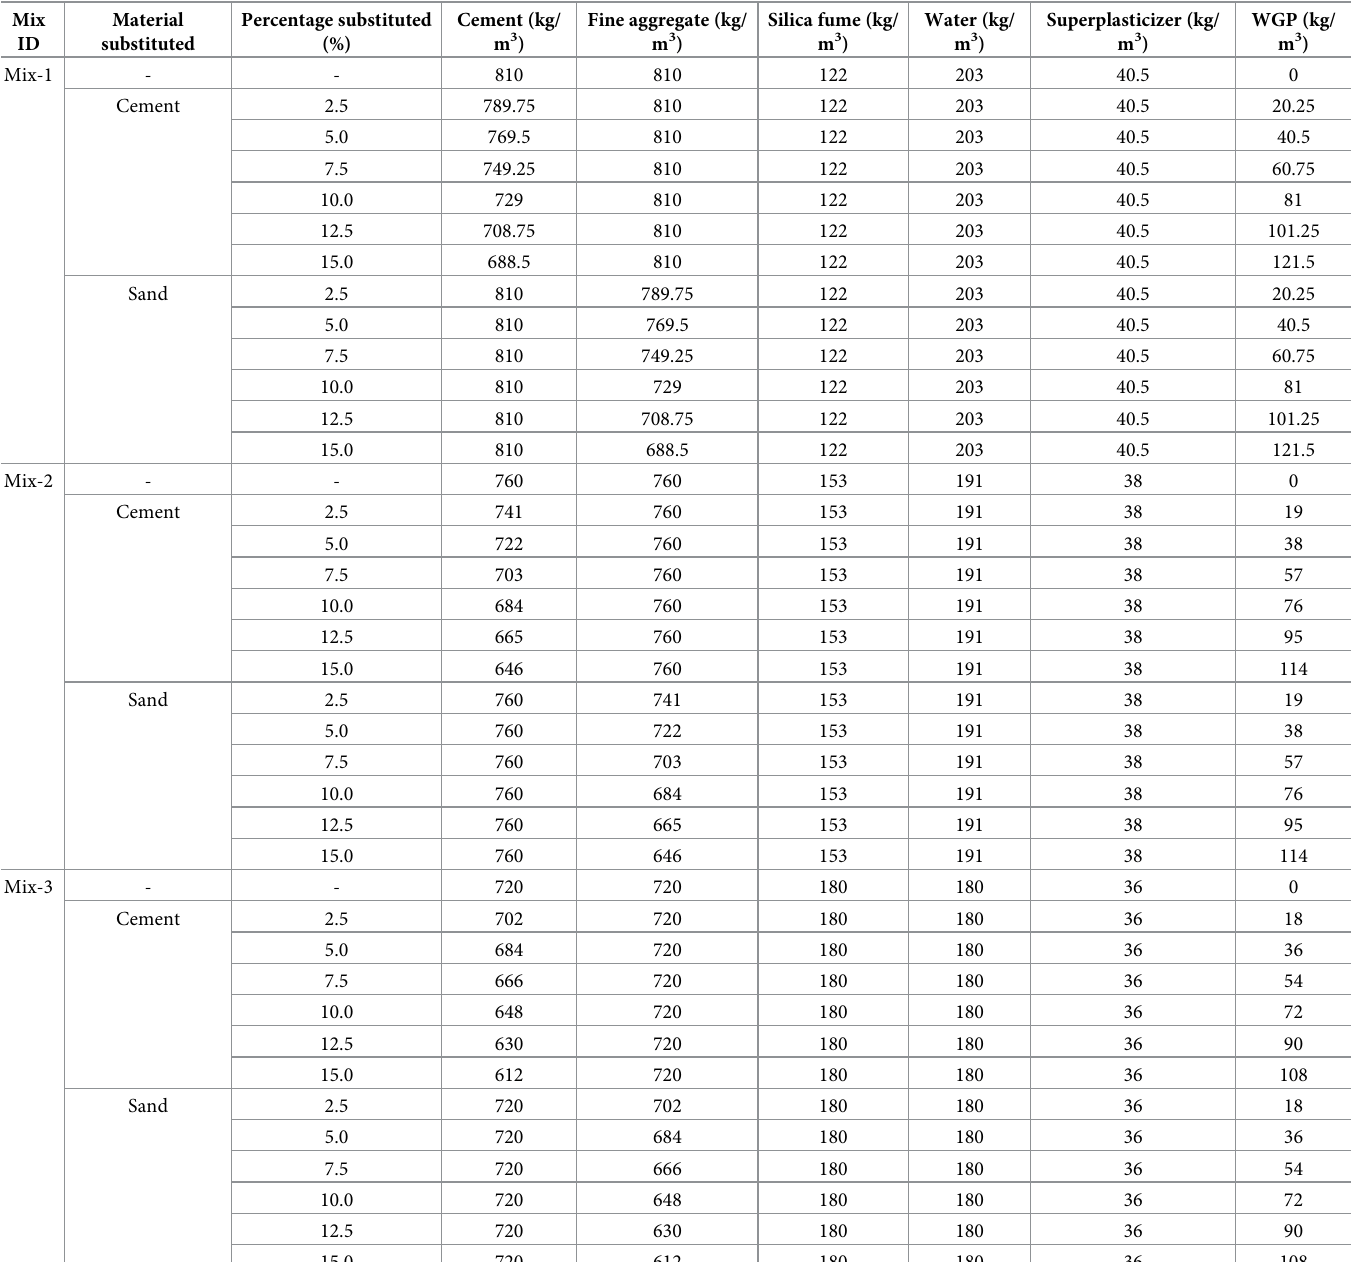
Table 1. Detail of mix proportion used during the experimental